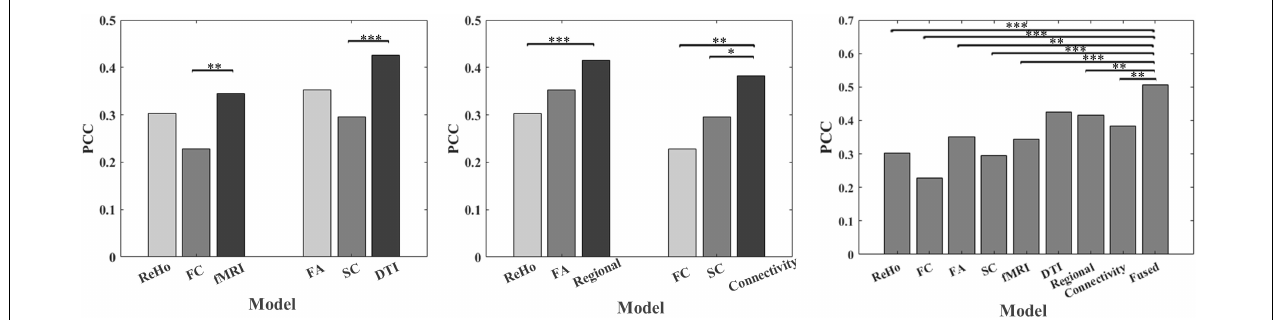
FIGURE 3 | Comparison of PCC between predicted and real laser pain threshold among models using different features. ∗ indicates p < 0.05, ∗∗ indicates p < 0.01, ∗∗∗ indicates p < 0.001.